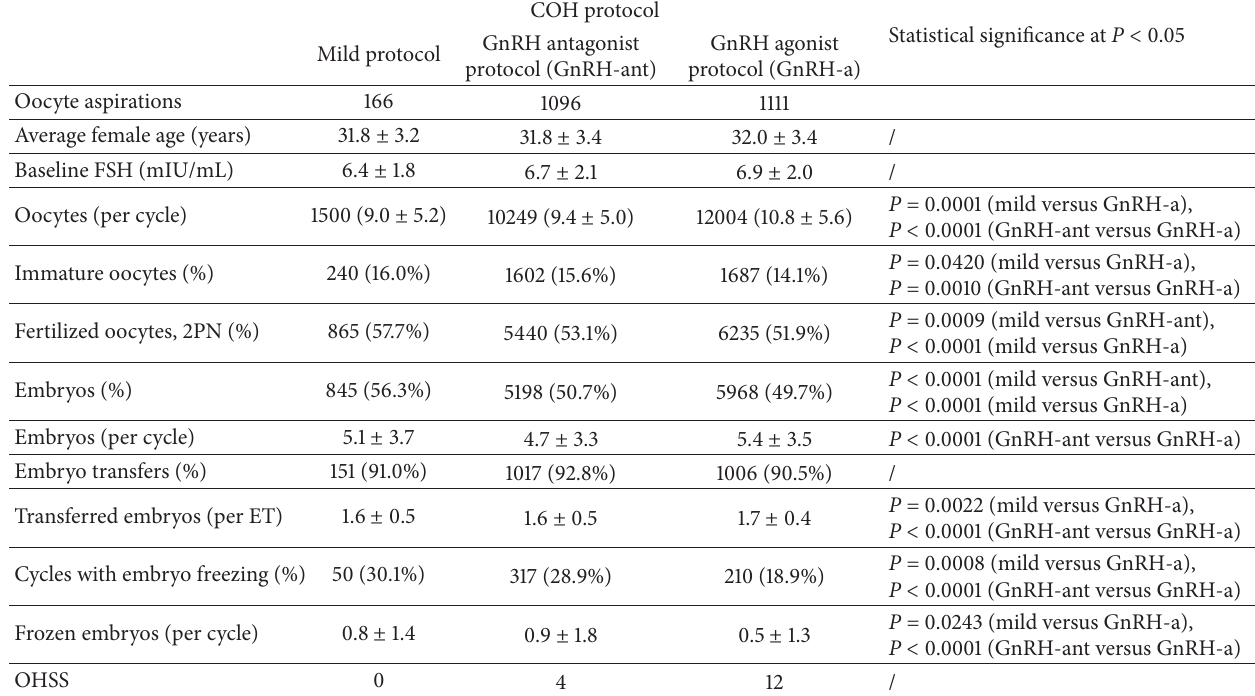
Table 1: The outcome of COH in terms of oocytes and embryos.